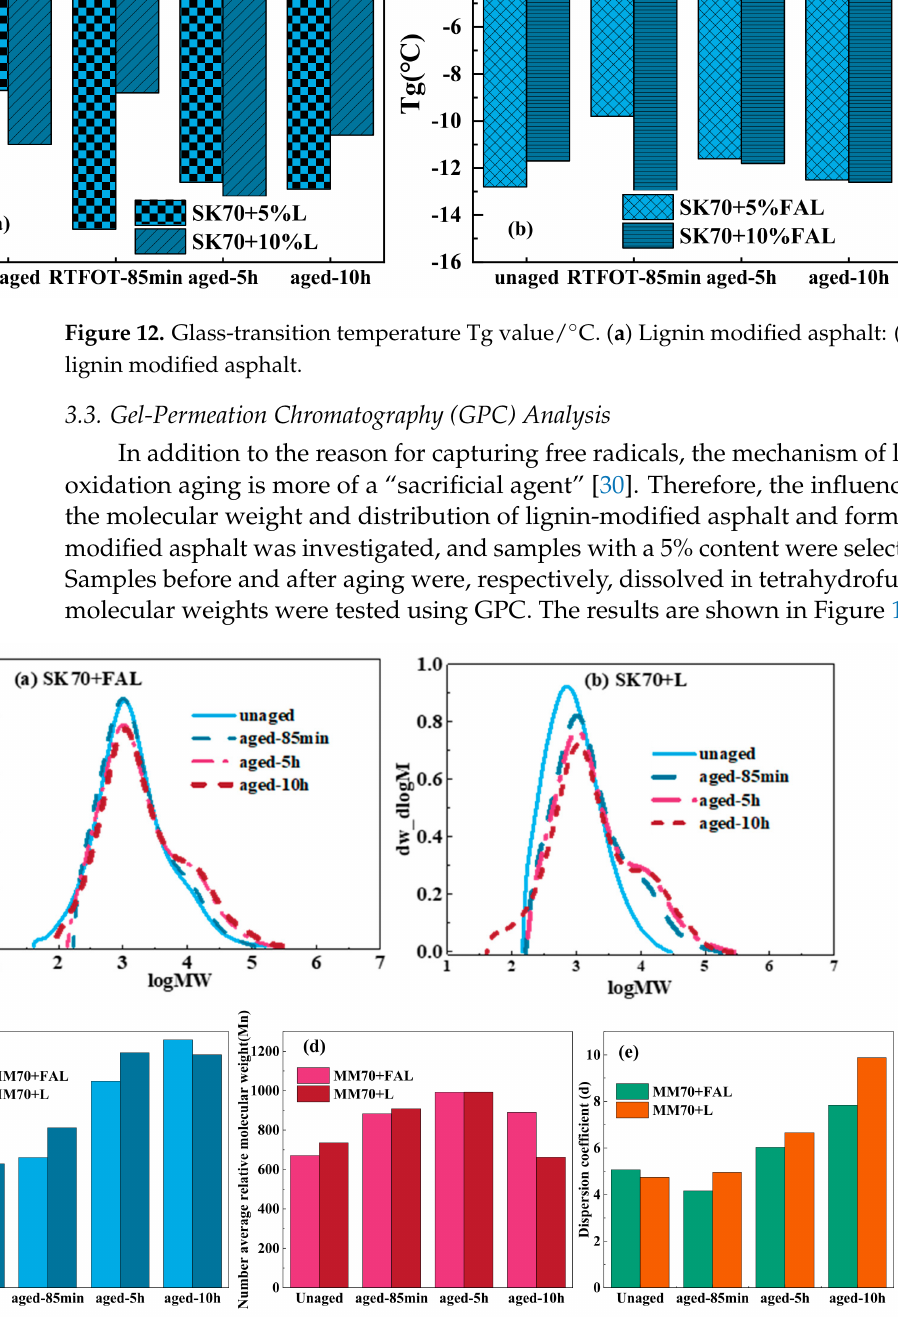
Figure 13. Gel chromatography of different modified asphalts with methyl lignin and different aging times. (( a ) SK70+FAL: ( b ) SK70+L: ( c ) Weight average molecular weight: ( d ) Number average molecular weight: ( e ) Dispersion